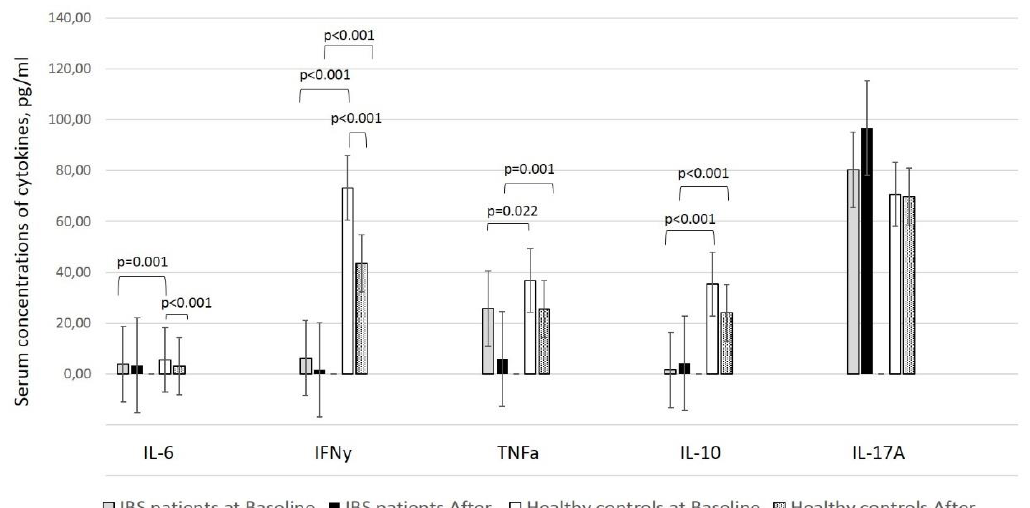
Figure 1. Cytokines and fecal IgA levels in fecal samples of healthy controls and patients with IBS before and after the supplementation of a product containing lactobacilli supplemented with larch arabinogalactan and colostrum. Results are presented as concentration (pg/mL or µg/mL) ± SD (range). Comparison of cytokines levels in fecal samples at baseline revealed that IL-6 ( p < 0.001), IFN- γ